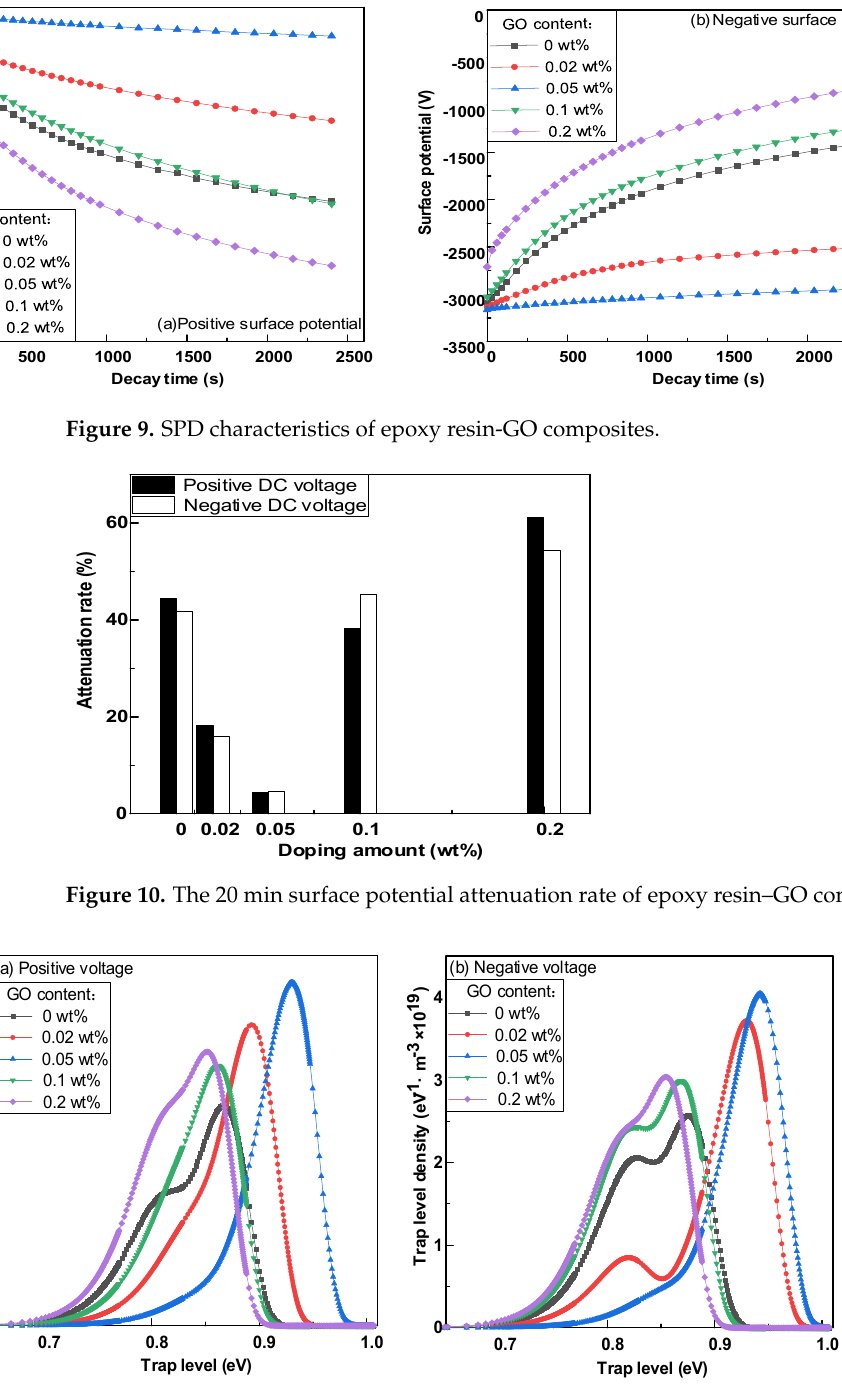
Figure 11. Surface trap distribution characteristics of epoxy resin-GO composites. ( a ) Surface trap distribution characteristics of epoxy resin-GO composites at positive voltage; ( b ) Surface trap distribution characteristics of epoxy resin-GO composites at negative voltage.